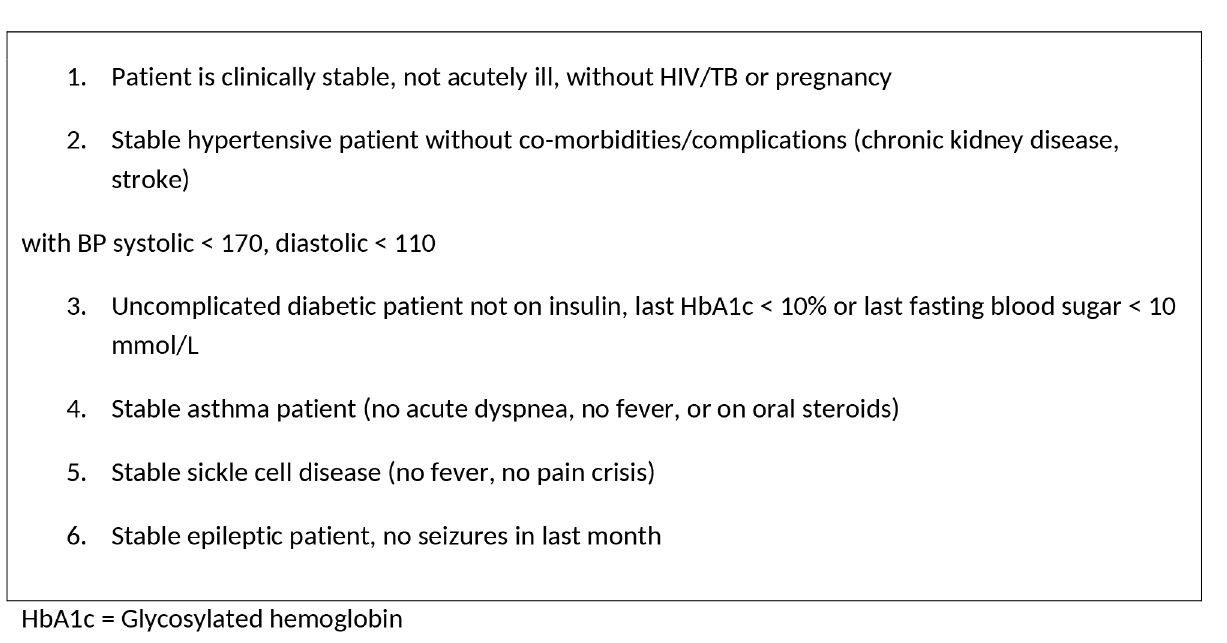
Fig 1. NCD patient inclusion criteria for nurse task shifting within primary care clinics in Kibera, Nairobi, Kenya (May-August 2014).